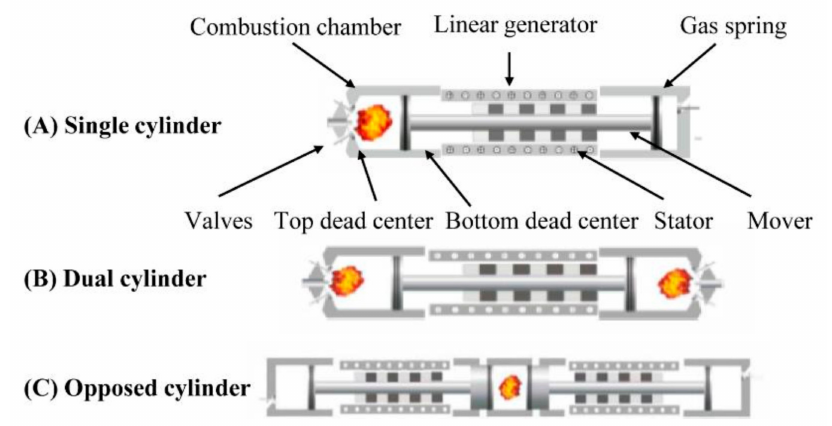
Figure 1. Three main configurations of the free-piston engine